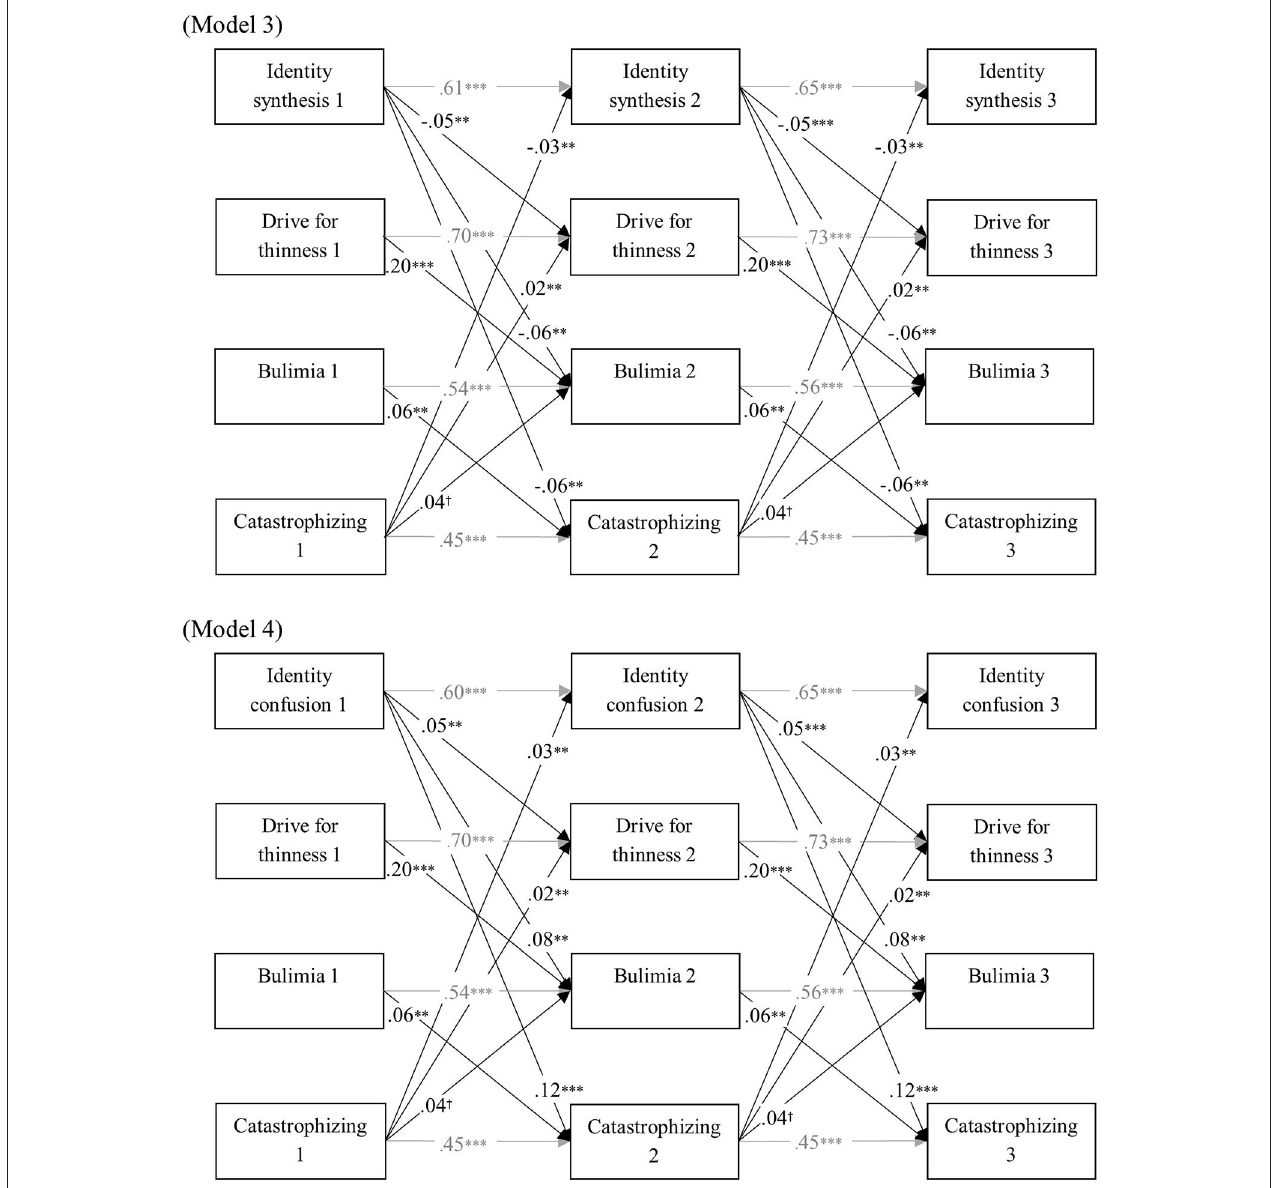
FIGURE 3 | Final cross-lagged models linking identity functioning, ED symptomatology, and catastrophizing. All models were controlled for age and gender. Within-time associations, associations with age and gender, and insignificant cross-lagged paths were not shown for reasons of clarity. All path coefficients are standardized. † p < 0.05, ** p < 0.01, *** p <